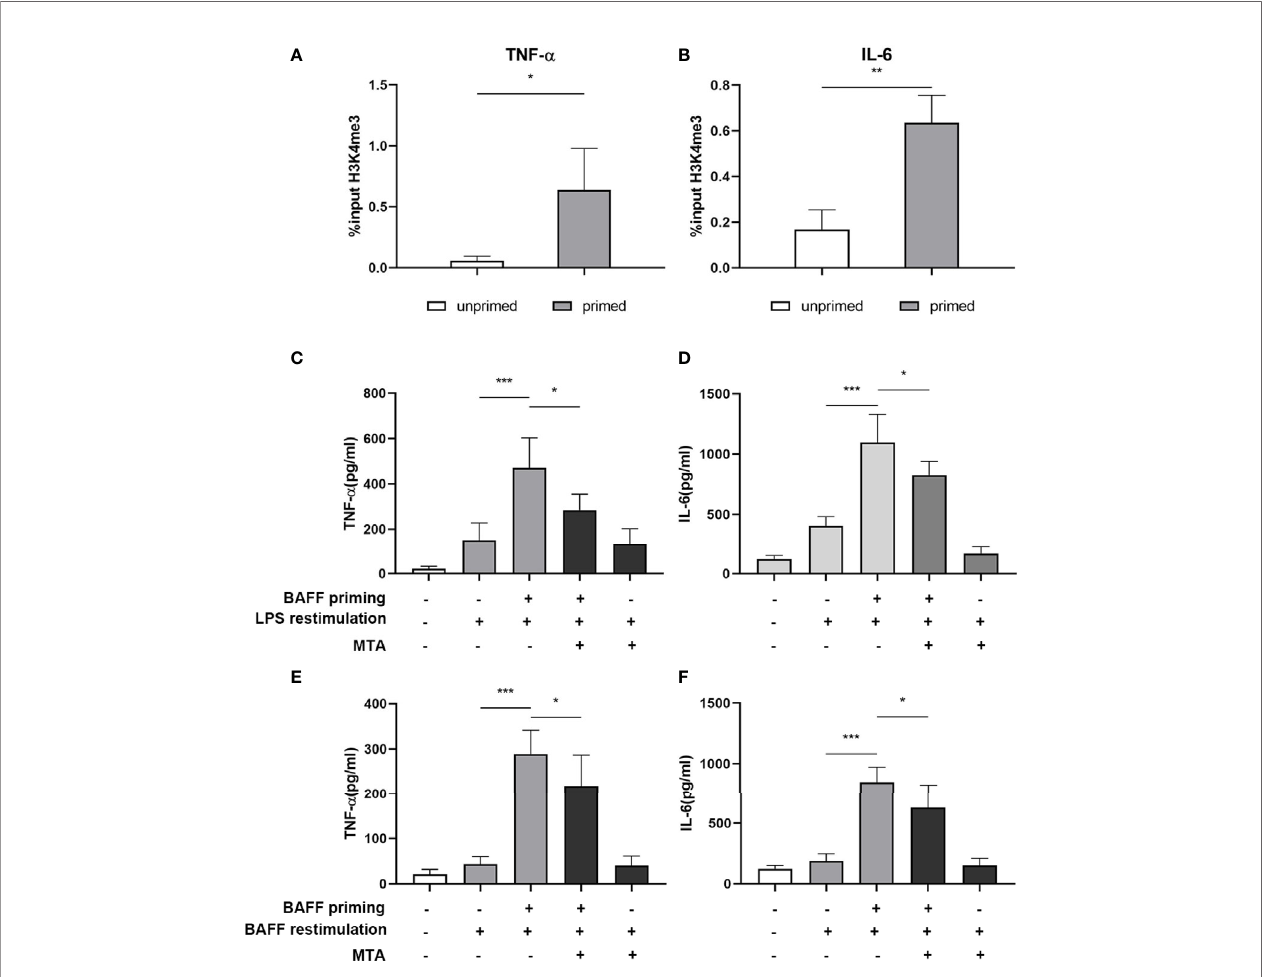
FIGURE 4 | BAFF priming induces an epigenetic trained immunity phenotype in BV2 cells. (A, B) BV2 cells were treated with 10ng/ml BAFF or vehicle for 24 h and kept for 5 days. ChIP assay was performed using an antibody against histone 3 lysine 4 trimethylation (H3K4me3) or control IgG. The enrichment of H3K4me3 at the promoters of TNF- a (A) and IL-6 (B) was quanti fi ed by quantitative real-time PCR. The results are expressed as % input and data are means ± SED (n = 6); t-test; *p < 0.05. (C, D) BV2 cells were treated as indicated with 10 ng/ml BAFF, 20 mM MTA (histone methyltransferase inhibitor) or vehicle for 24 h, rested for 5 days, on day 6 treated with LPS restimulation for 24 h. TNF- a (C) and IL-6 (D) were measured in the supernatants by ELISA on day 7(n = 12). On day 6, BV2 cells were restimulated with BAFF instead of LPS. On day 7, TNF- a (E) and IL-6 (F) were measured in the supernatants (n = 12). Data are means ± SED (n = 12); Kruskal- Wallis test with Turkey post hoc test; *p < 0.05, **p < 0.01, and ***p <